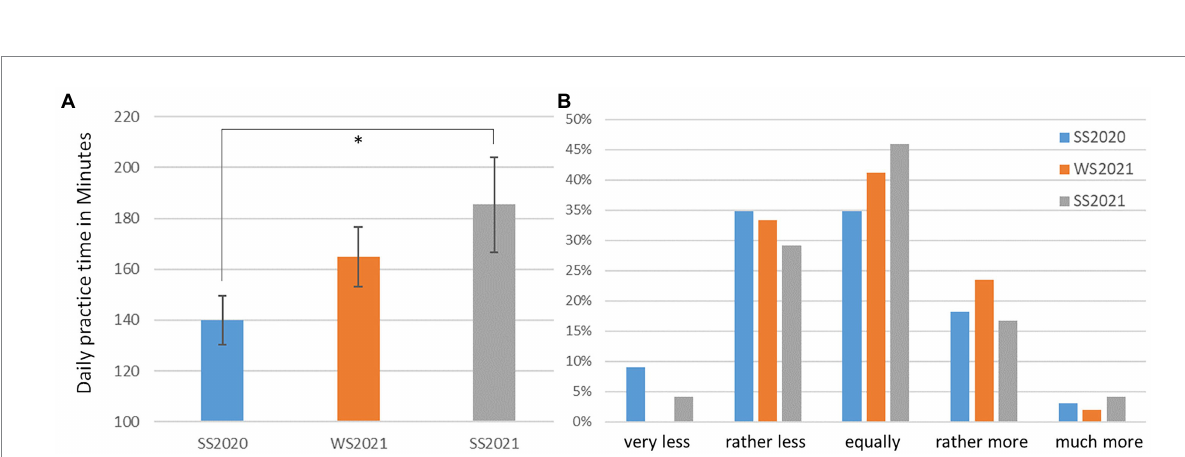
FIGURE 4 (A) Left: the mean daily practice time in each semester (error bars present the standard error of the mean, * p < 0.05). (B) Right: distribution of the answers to the question of how the practice time differed from usual semesters before the pandemic.